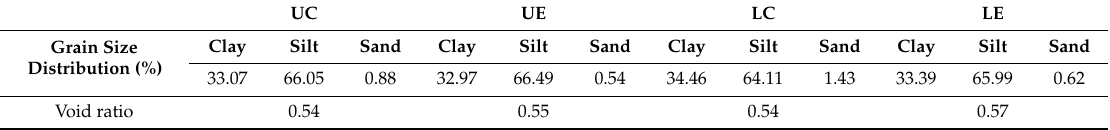
Table 6. Grain size distribution and void ratio in di ff erent positions of the soil at the end of SVP. UC UE LC LE Clay Silt Sand Clay Silt Sand Clay Silt Sand Clay Silt Sand Grain Size Distribution (%)